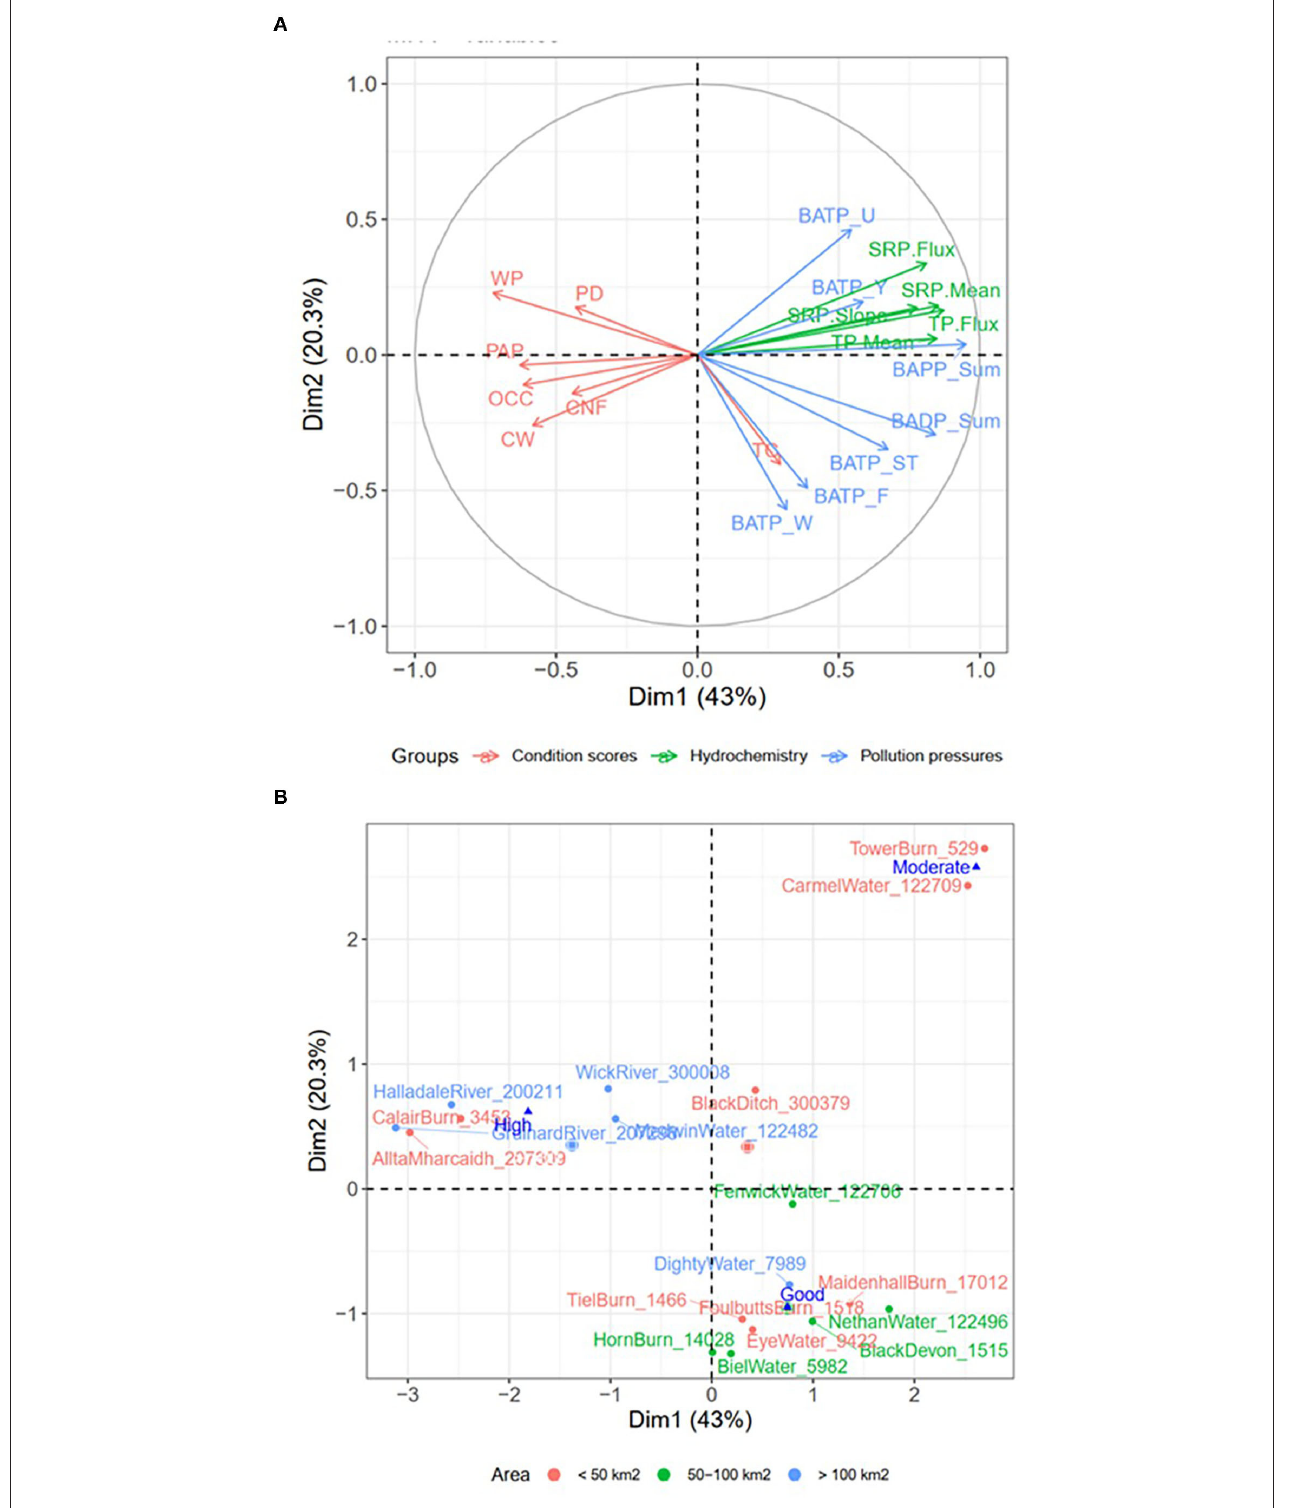
FIGURE 4 | Multiple Factor Analysis (MFA) biplot in two dimensions split into (A) parameters and (B) catchments and waterbody diatom ecological status, with colour keys as separately noted. In (A) parameters are represented by rays coloured according to parameter group; in (B) sites and WFD ecological status clusters are identified, represented by sites with colour denoting catchment